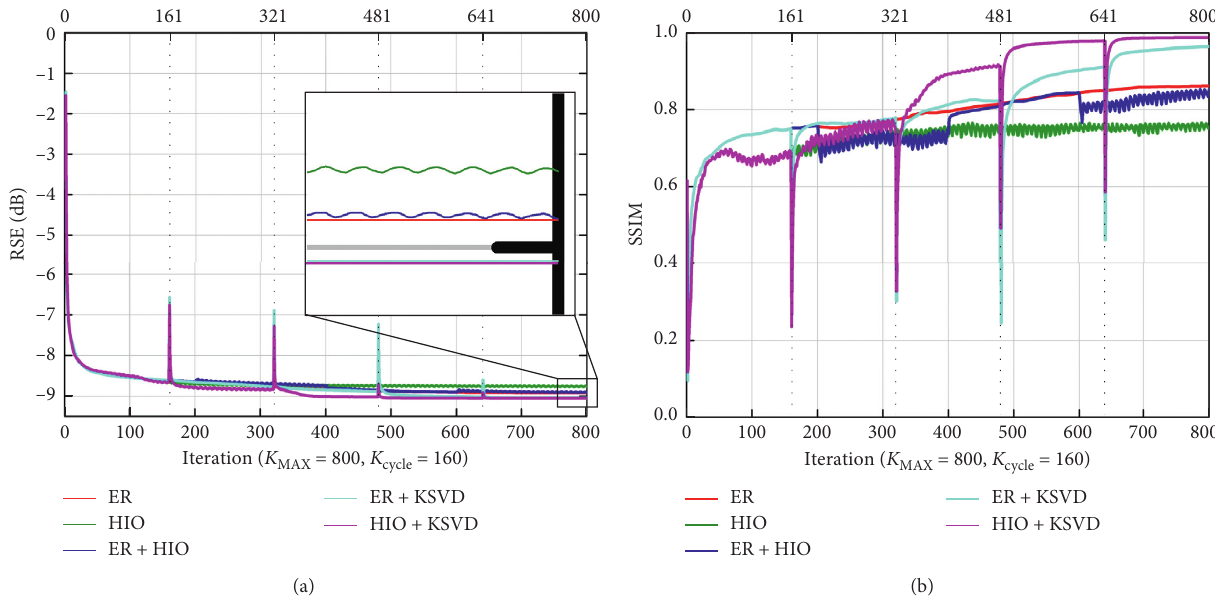
Figure 9: Taking the text object of “NCTU” as an example, two performance metrics were evaluated in the five PR algorithms. (a) RSE and (b) SSIM. Since KSVDis executed ateach iterationcycle andresultsinspikes,the perturbationenables thealgorithm tojump outofthe stagnantlocal optimum.